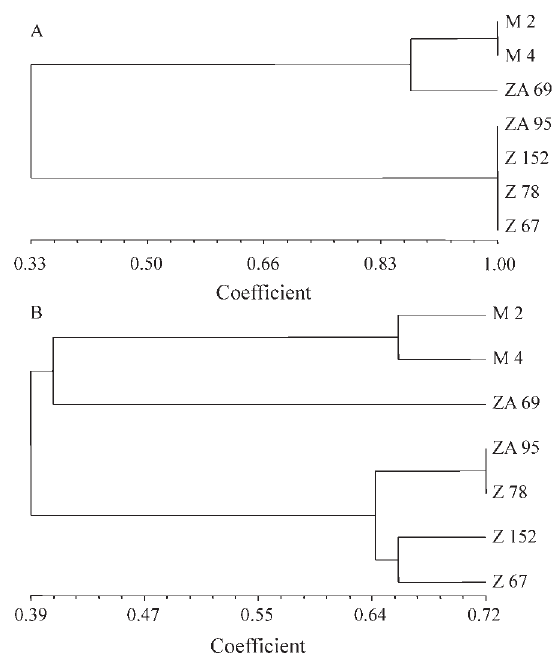
Figure 1 - Panel A – Dendrogram inferred from the RFLP profiles ob- tained by digestion of total DNA of Herbaspirillum strains with restriction endonucleases Hin dIII or Dra I. Panel B – Dendrogram inferred from RAPD profiles of the Herbaspirillum strains. Similarities were calculated using Dice’s coefficient, and clustering was achieved by UPGMA (Sokal and Michener, 1995).